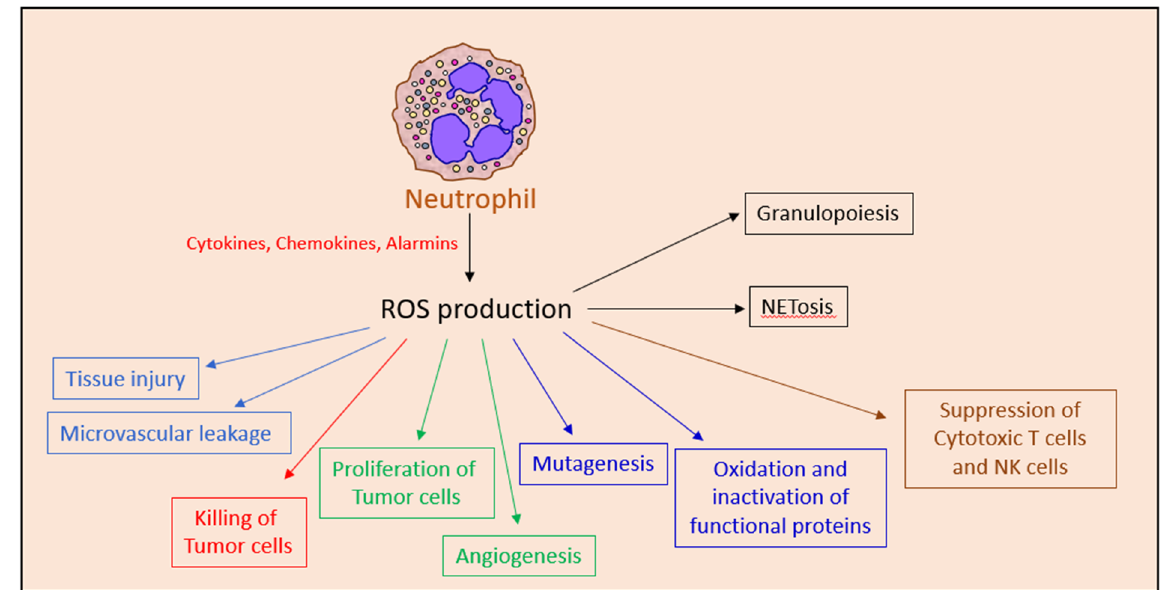
Figure 4. The opposite effects of reactive oxygen species (ROS) in neutrophil tumor biology. ROS produced by neutrophils might either provide the cytotoxic hit resulting in tumor cell death or induce proliferation of the tumor cells. In addition, ROS might lead to tissue injury, angiogenesis and mutagenesis, which further support the cancerous phenotype. On top of this, neutrophil-produced ROS can suppress cytotoxic T cell and NK cell functions necessary for the ultimate tumor cell rejection.